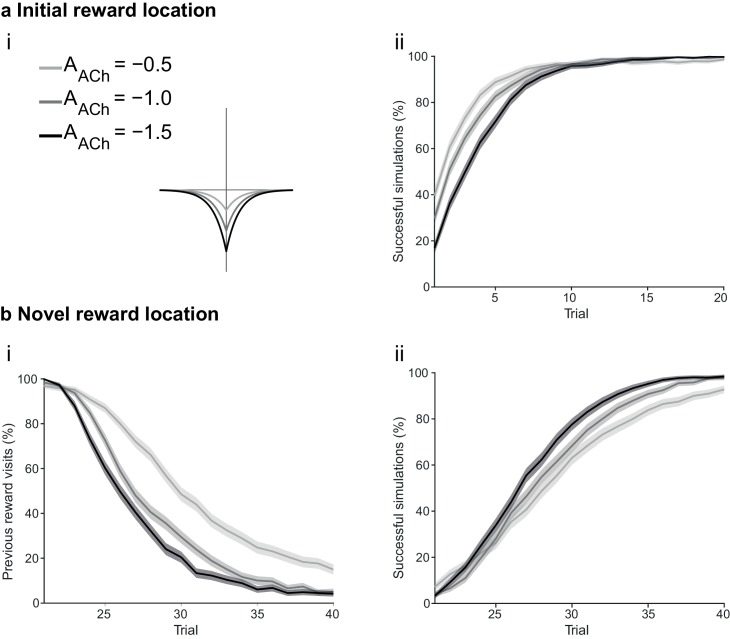
The magnitude of acetylcholine effect affects unlearning.(a) The agents are subject to the same learning paradigm as in Figure 4. Difference in the magnitude of cholinergic effect does not affect performance. (ai) The parameters used for Small, Medium and Large magnitudes of acetylcholine effect are specified in the legend; darker colors correspond to larger magnitudes of cholinergic effect. (aii) Learning curve presented as a percentage of successful simulations over successive trials (trials 1–20; 1000 simulation). The initial difference in performance is due to reduced speed, a consequence of the online depression. (b) Learning of a displaced reward location becomes more efficient with larger magnitudes of acetylcholine effect. (bi) The percentage of visits to the previously rewarded location is lower for conditions with larger magnitudes of acetylcholine effect (trials 21–40; 1000 simulation). (bii) Learning of the novel reward location is also faster for Medium and Large conditions. The shaded area (aii and bi-ii) represents the 95% confidence interval of the sample mean.